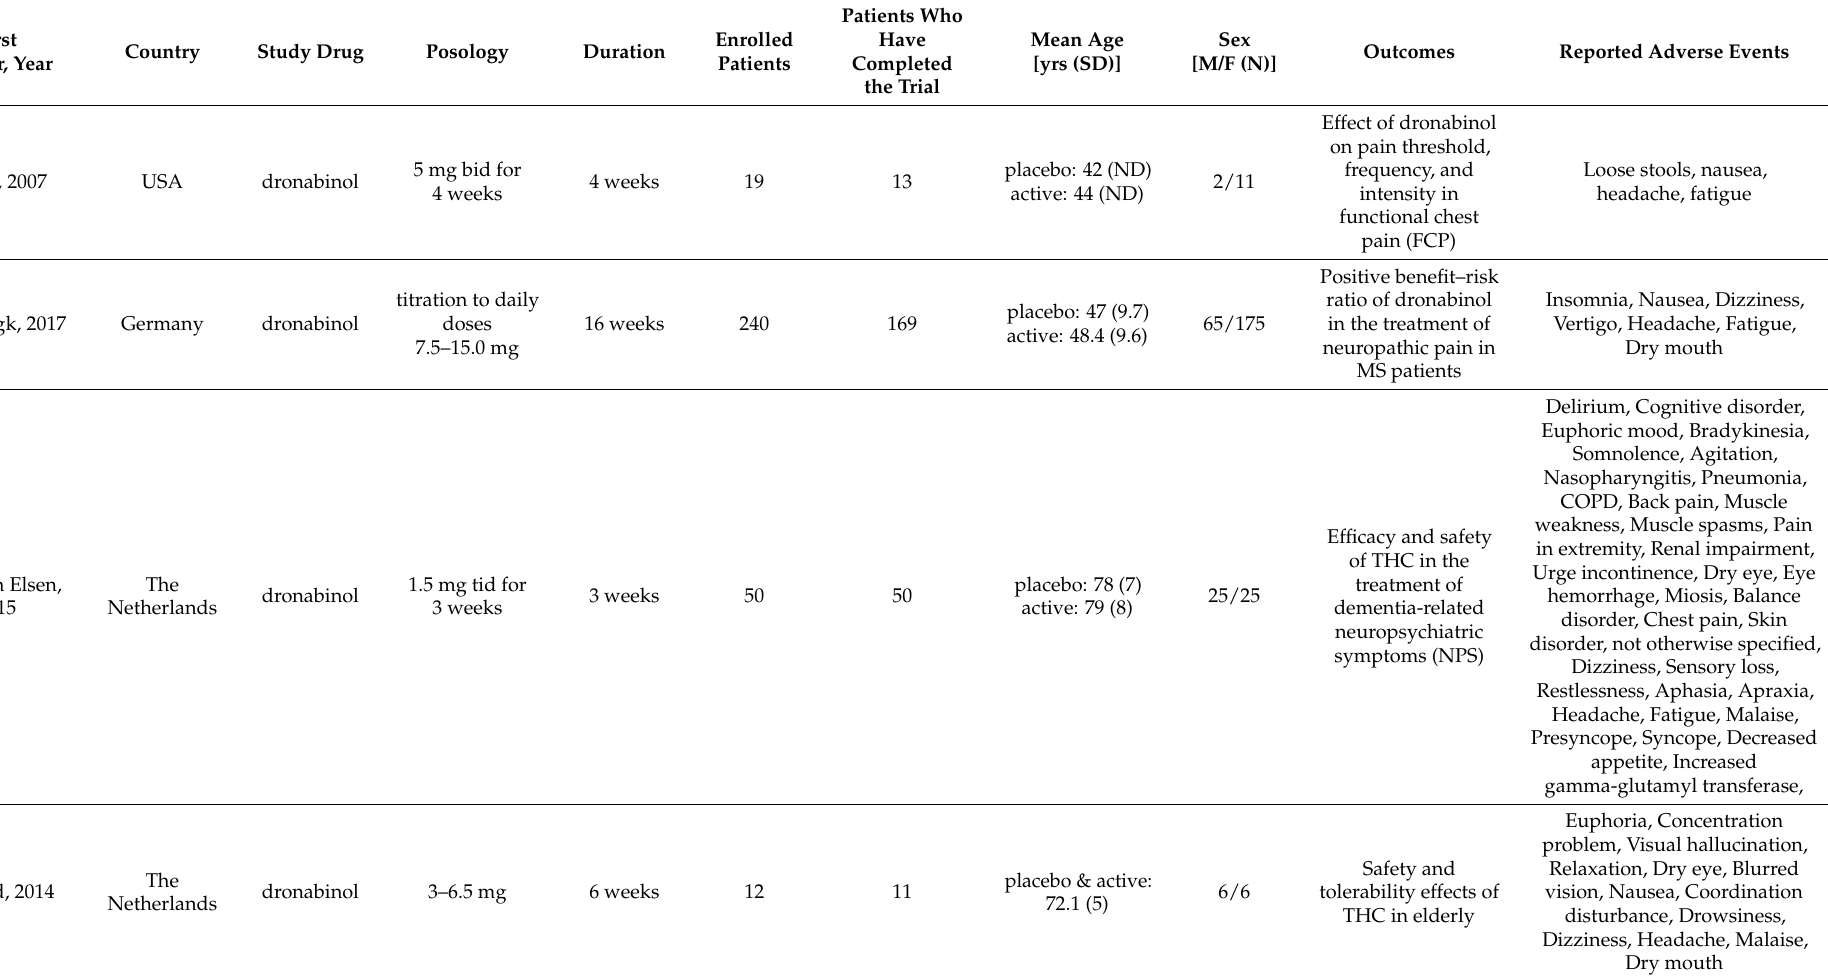
Table 2. Summary of dronabinol